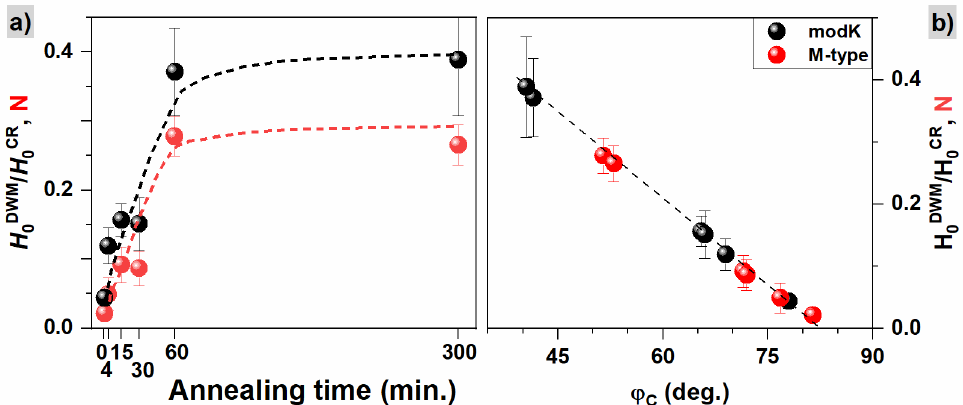
Figure 8. ( a ) Ratio between the nucleation field of the inverse domain wall and the rotation field of the magnetization vector, 𝐻 0𝐷𝑊𝑀 /𝐻 0𝐶𝑅 , in the modified Kondorsky model and ratio of demagnetiza- tion factors 𝑁 in the M-type model as a function of annealing time. ( b ) Correlation of the 𝐻 0𝐷𝑊𝑀 /𝐻 0𝐶𝑅 parameter with the critical angle 𝜑 𝐶𝑚𝑜𝑑𝐾 in the modified Kondorsky model and the ra- tio of demagnetization factors 𝑁 with 𝜑 𝐶𝑀−𝑡𝑦𝑝𝑒 in the M-type model.